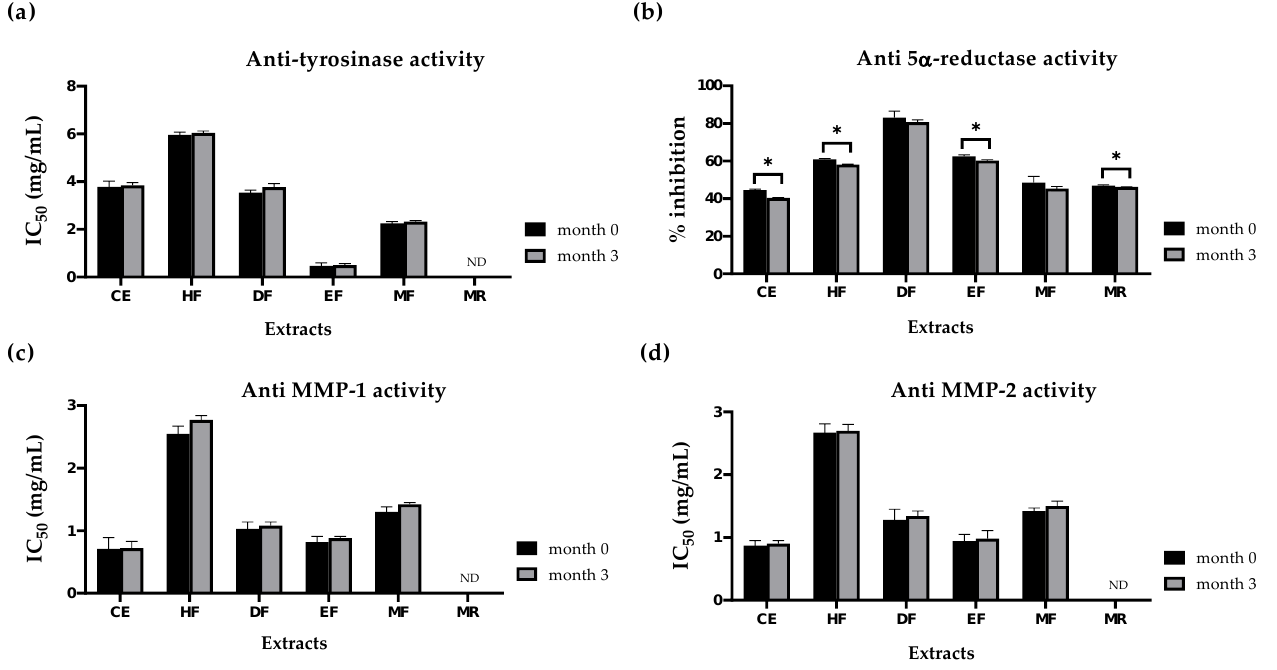
Figure 10. Stability potentials of the bioactivities of E. debile extracts during storage; ( a ) anti-tyrosinase activity; ( b ) anti-5 α -reductase activity; ( c ) anti MMP-1 activity; and ( d ) anti MMP-2 activity. Crude extract (CE) was successively partitioned to produce hexane fraction (HF), dichloromethane fraction (DF), ethyl acetate fraction (EF), methanol fraction (MF), and methanol insoluble residue (MR), respectively. All data are presented as mean ± SD of triplicates. * indicates statistically significant differences of means between month 0 and month 3 based on Student’s t -test ( p -value <